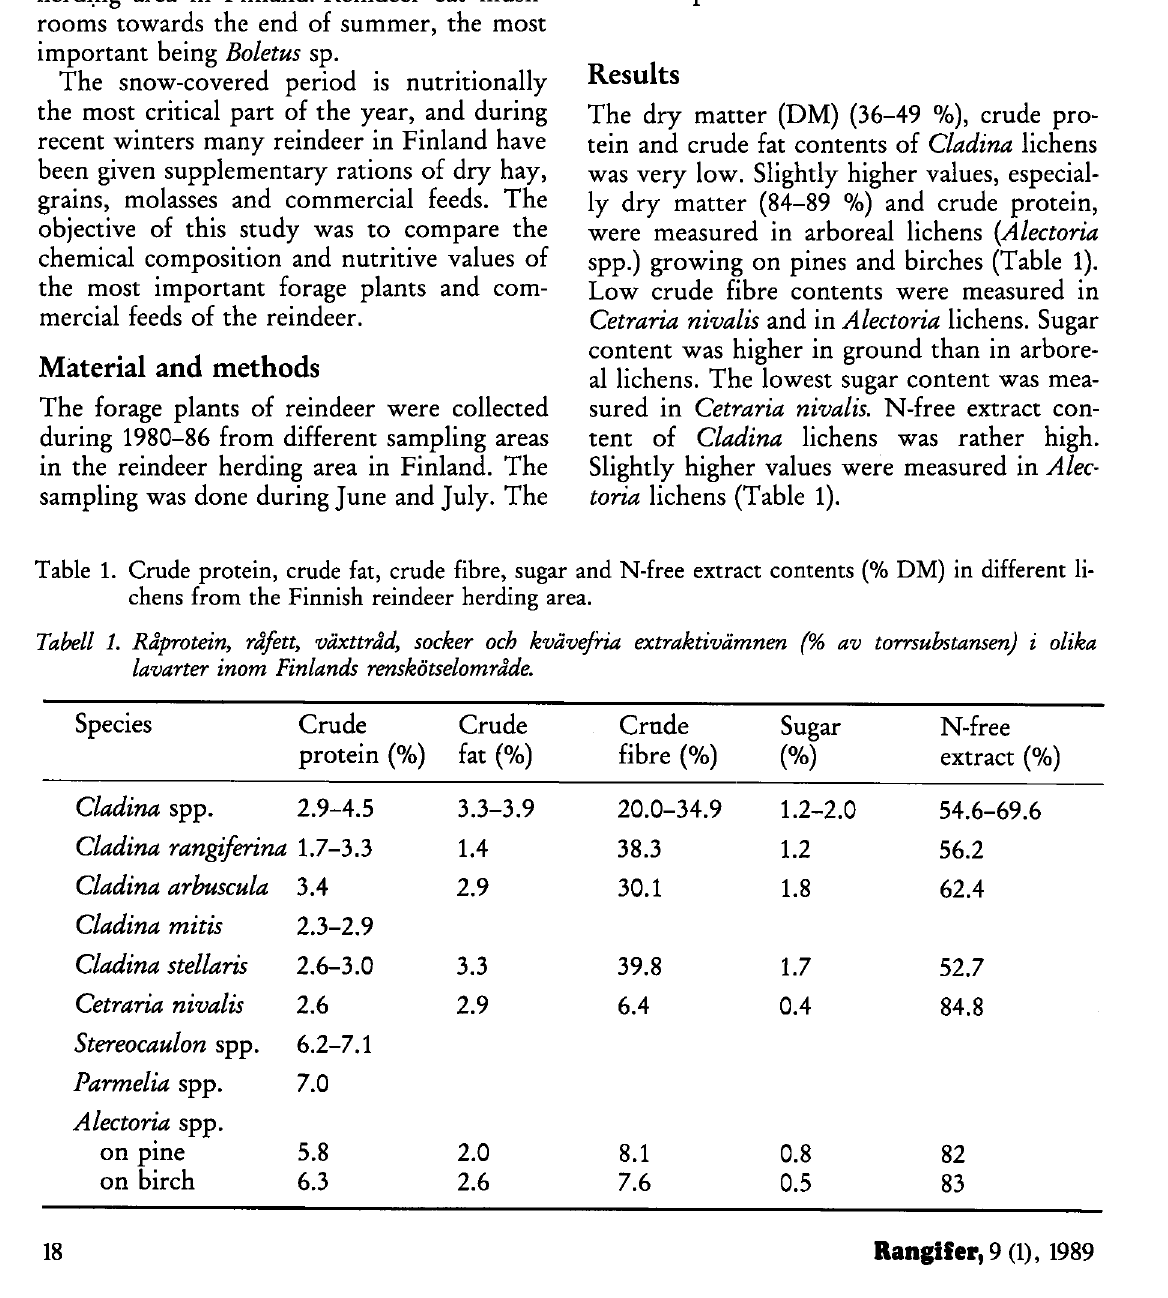
Table 1. Crude protein, crude fat, crude fibre, sugar and N-free extract contents (% DM) in different li chens from the Finnish reindeer herding area. Tabell 1. Rdprotein, rdfett, vdxttrdd, socker och kvavefria extraktivåmnen (% av torrsubstansen) i olika lavarter inom Finlands